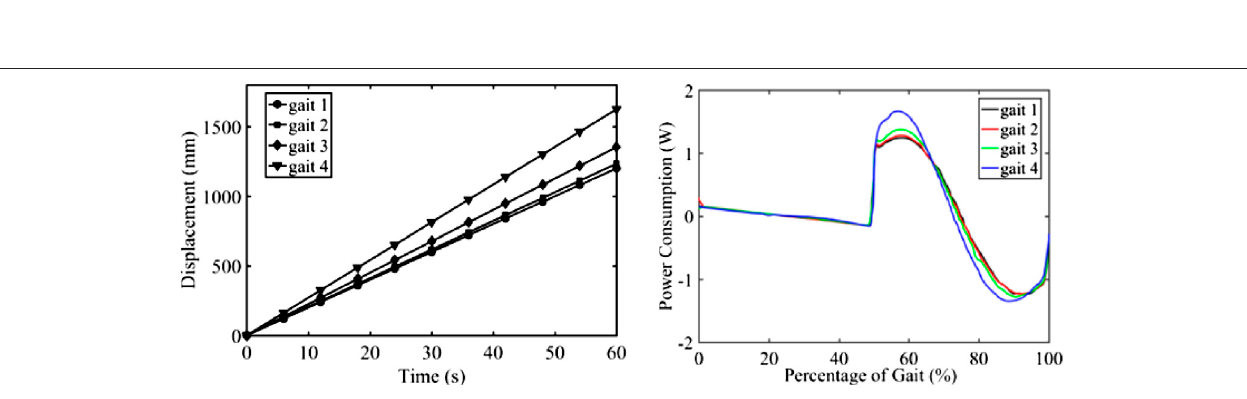
FIGURE 12 | Horizontal displacement and energy consumption of the